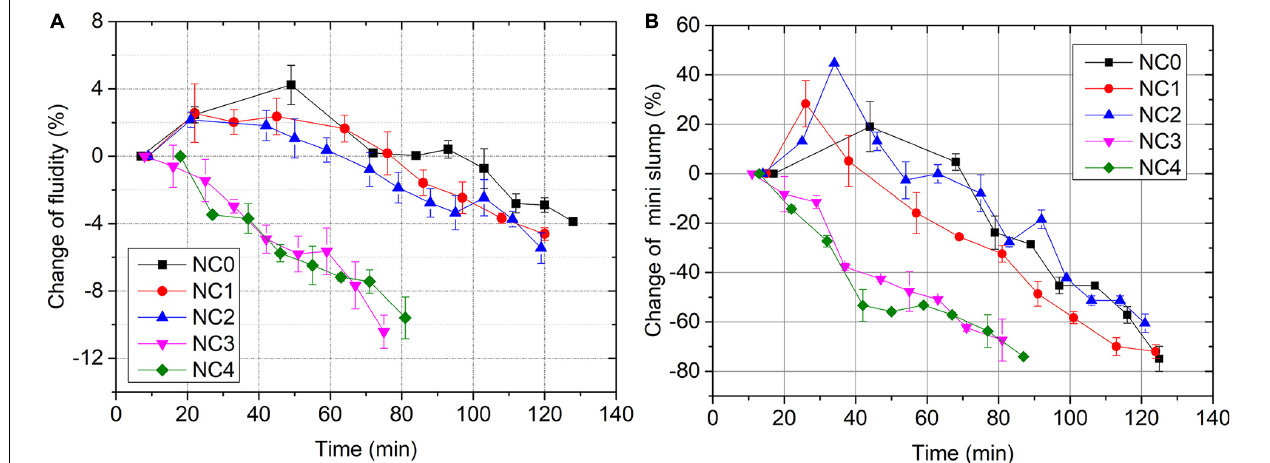
FIGURE 8 | Change of fluidity and mini-slump of mixtures: (A) fluidity, (B) mini-slump.